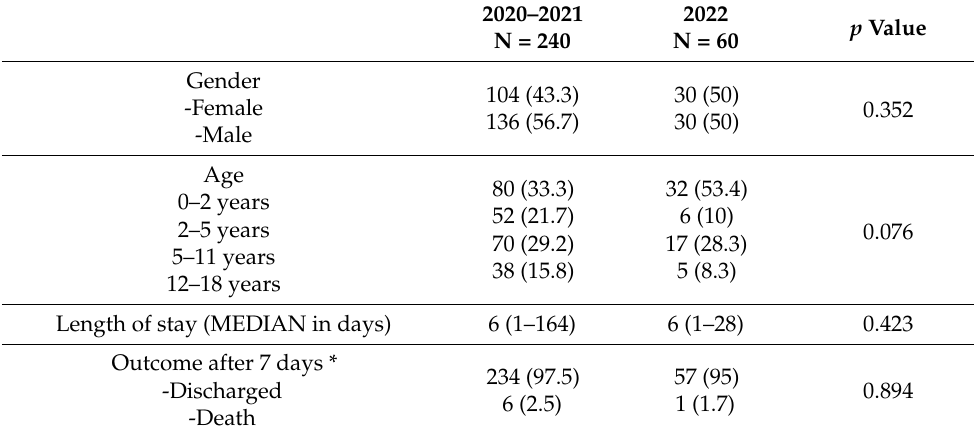
Table 1. Demographic data of admitted cases in two pediatric hospitals (Rio de Janeiro city, 1